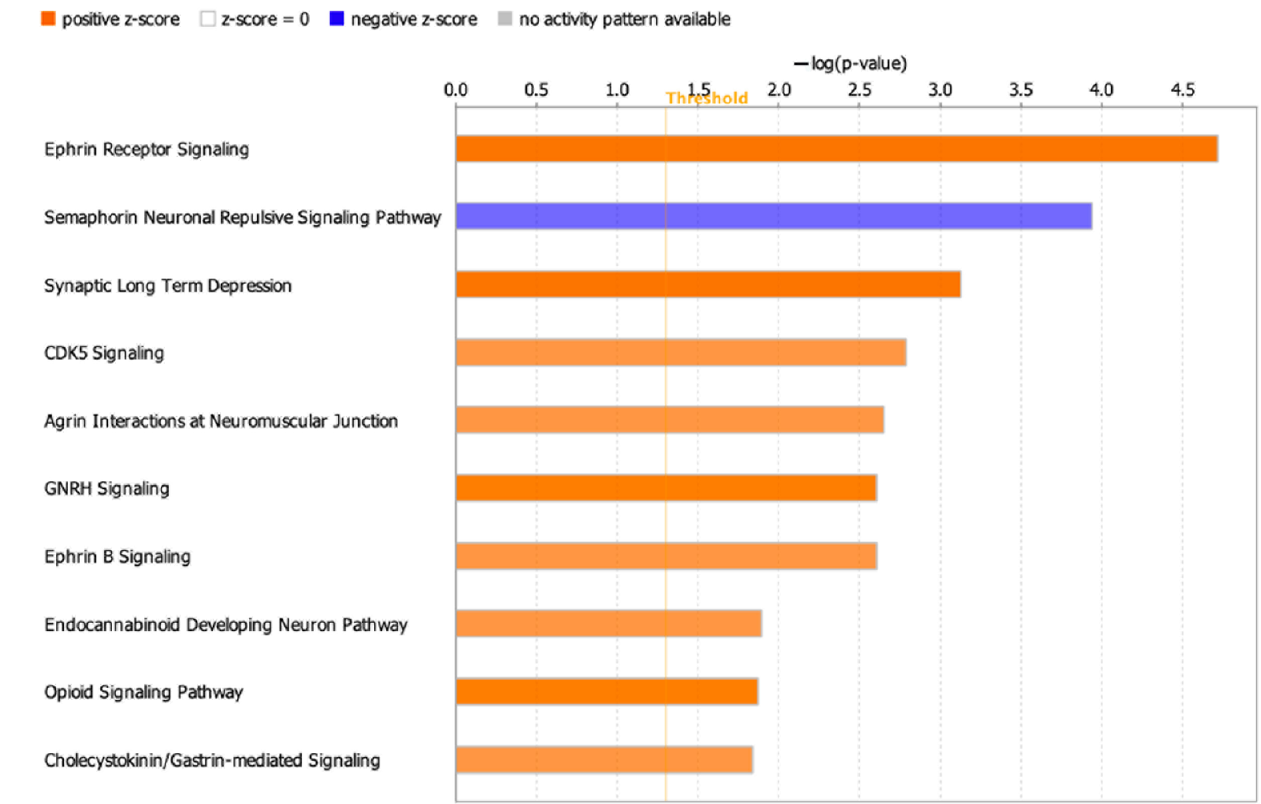
Figure 3. Enriched pathways associated with neurodevelopment and nervous system signaling in the oxy-exposed neuroglial cultures. Orange bars indicate upregulated pathways and blue denote downregulated. All pathways are significant with p < 0.05 and an absolute z -score ≥ 1; the threshold line corresponds to p < 0.05.